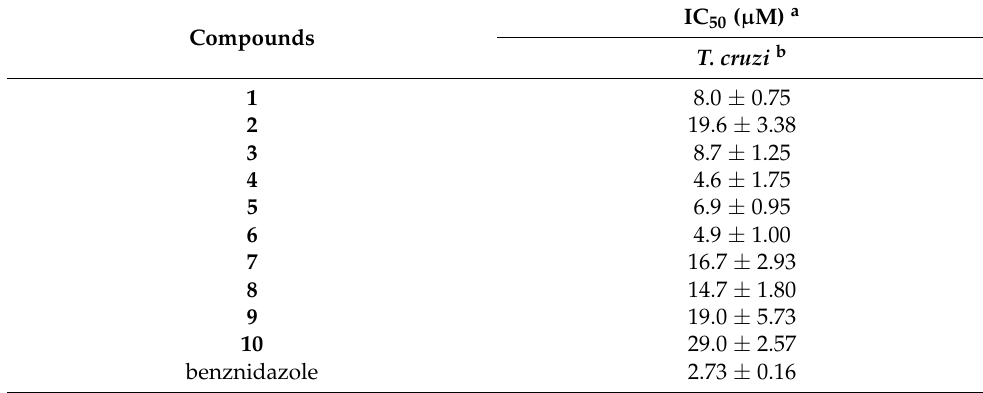
Table 2. Antitrypanosomal activity against T. cruzi of bufadienolides isolated from R. alata .